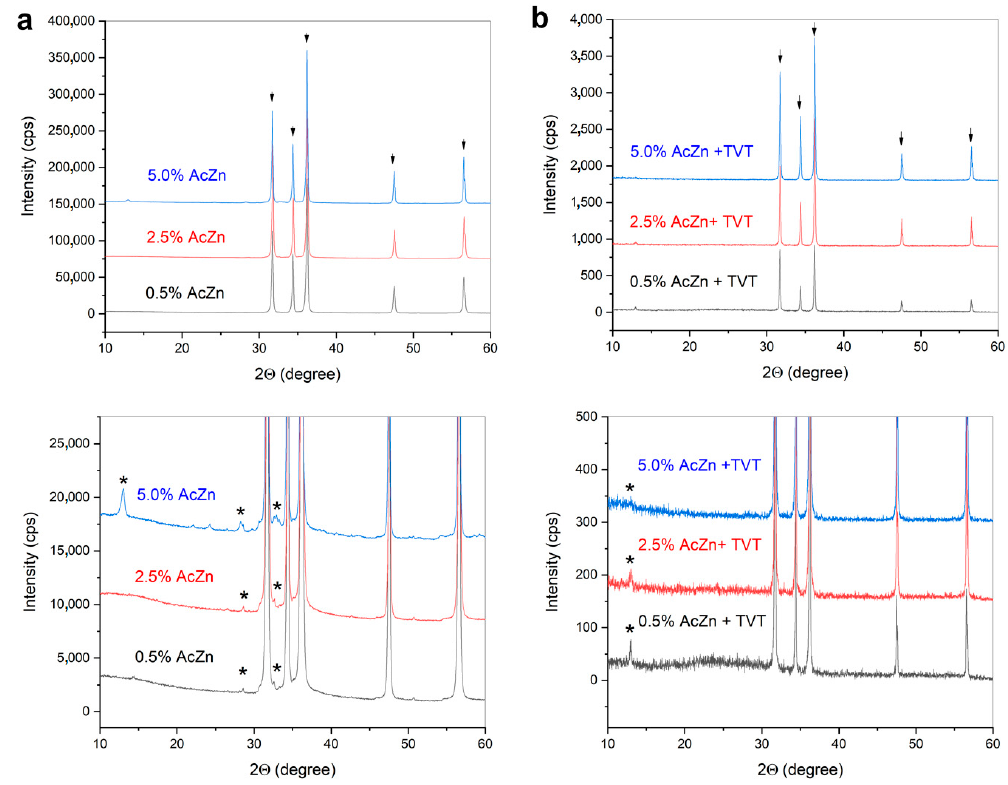
Figure 7. XRD patterns of ZnO ceramics prepared by CSP with double PTFE sealing from ZnO powders impregnated by 0.5–5.0 wt.% ZnAc, ( a ), ZnO powders after impregnation by 0.5–5.0 wt.% ZnAc followed (2P). Arrows indicate ZnO (COD #9008877), asterisk indicated traces of the LBZA